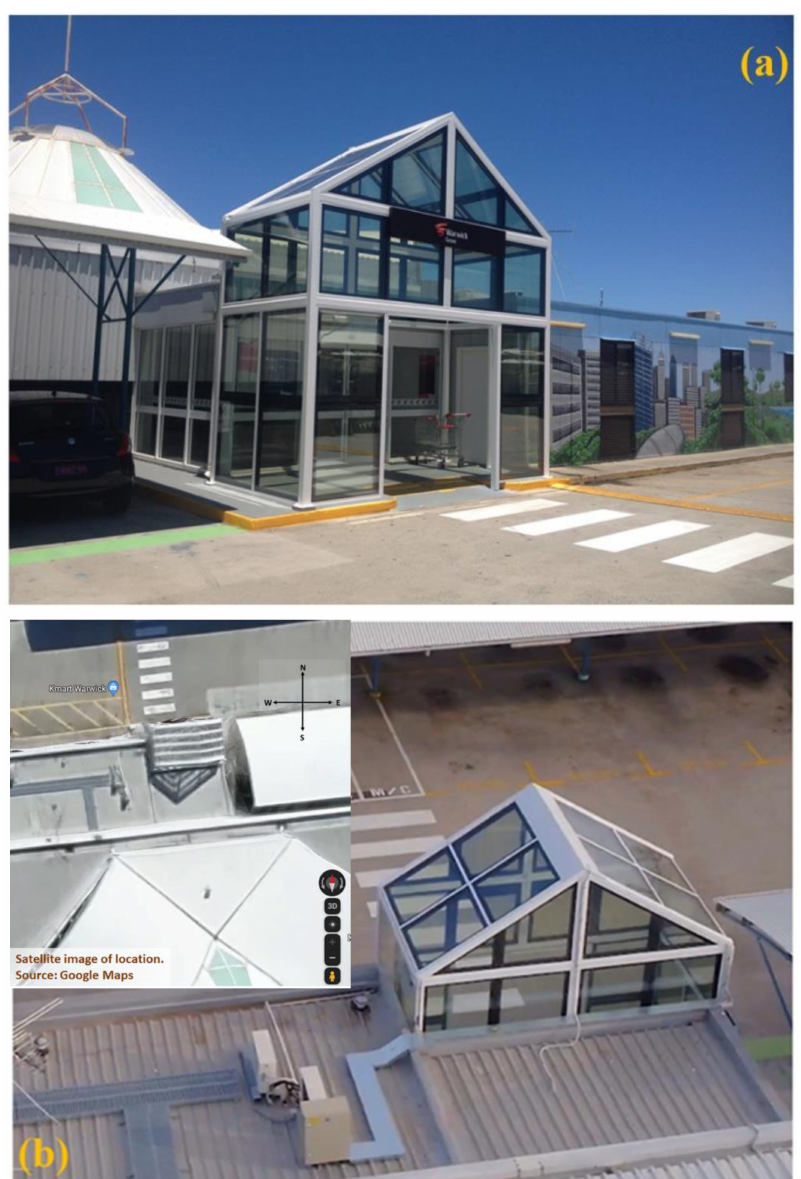
Figure 1. Entrance porch (atrium) of Warwick Grove Shopping Centre in Warwick (Perth, WA, Australia) constructed using 18 solar windows supplied by Clearvue Technologies Ltd. (Perth, WA, Australia). ( a ) front view and ( b ) top view, with the inset showing satellite image of the same entrance atrium structure prior to solar windows installation. The site orientation-related data are also shown; the roof sides are tilted at ≈ 37 ◦ from horizontal